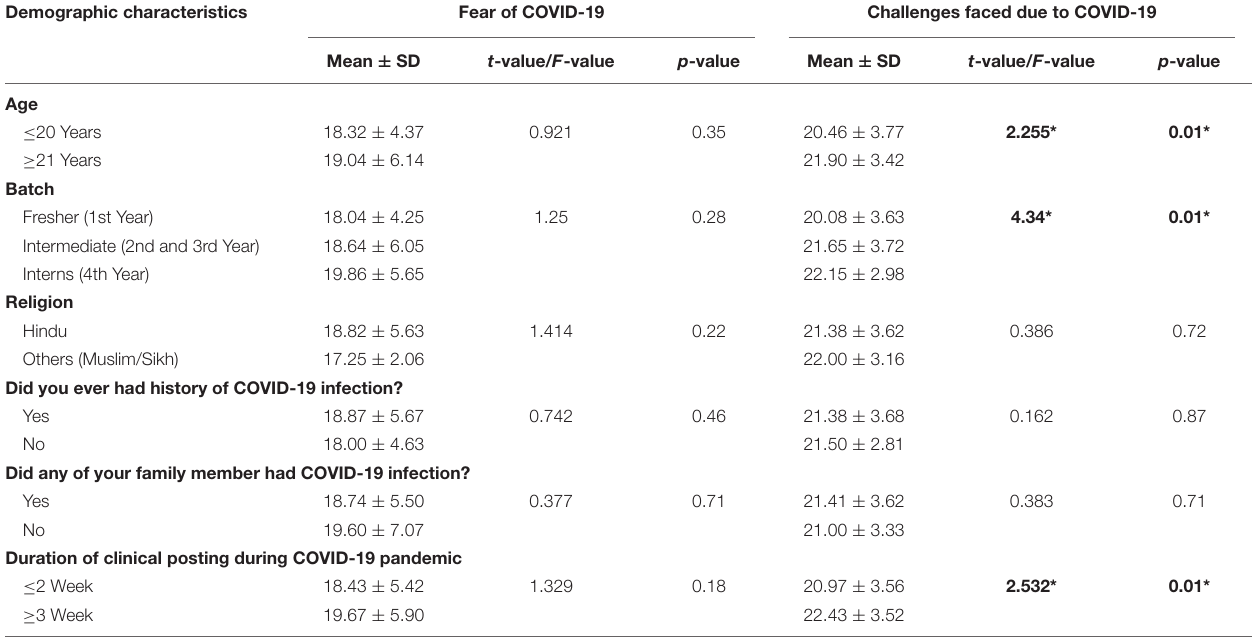
TABLE 4 | Independent t -test and ANOVA for association of fear and challenges due to COVID-19 with demographic variables among participants. Demographic characteristics Fear of